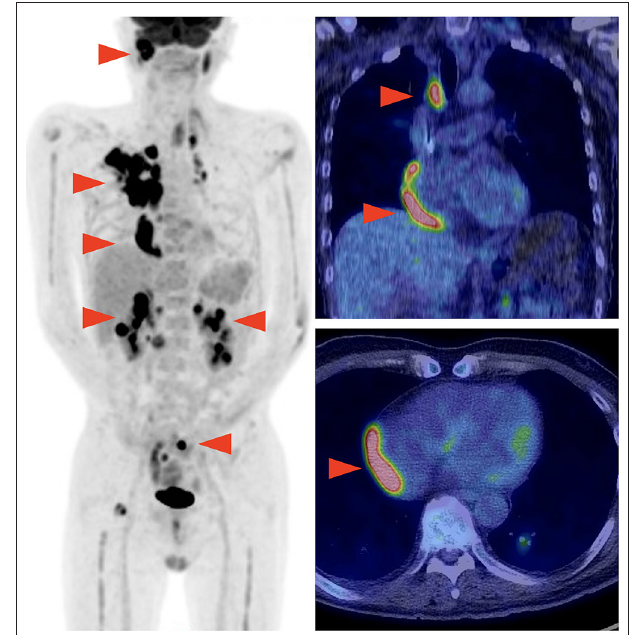
FIGURE 1 | Positron emission tomography-computed tomography performed before chimeric antigen receptor T (CAR-T) cell therapy showing multiple lymphoma lesions including the site adjacent to the right